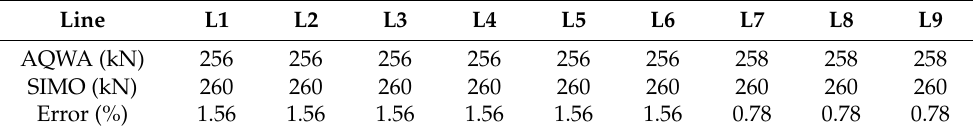
Table 7. Comparison of pre-tension.